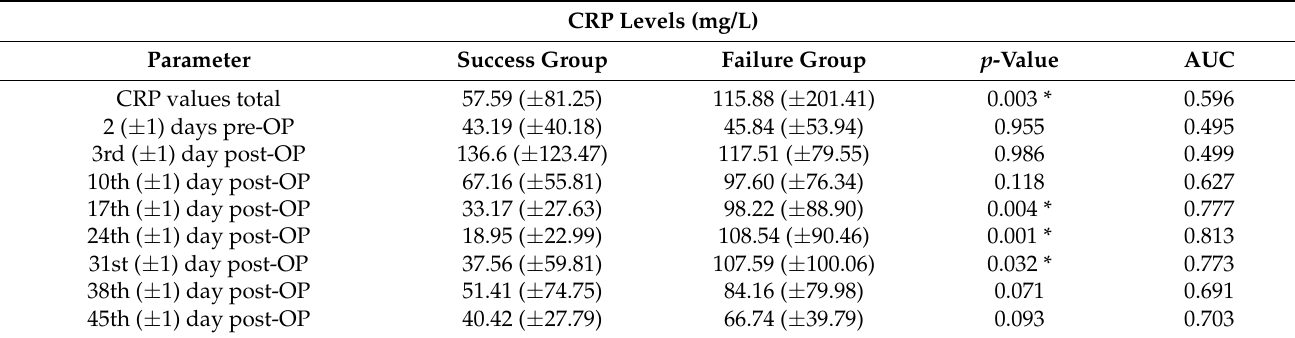
Table 4. Comparison of C-reactive protein (CRP) values’ trend pre/postoperatively after resection arthroplasty between successful two-stage procedures (success group) and failed two-stage procedures (failure group).